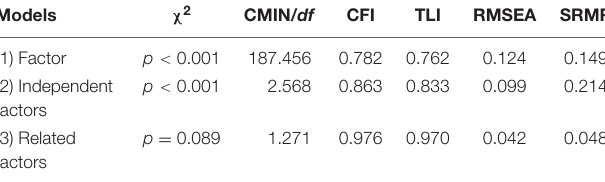
TABLE 2 | Goodness-of-fit Indexes of the Proposed Models.